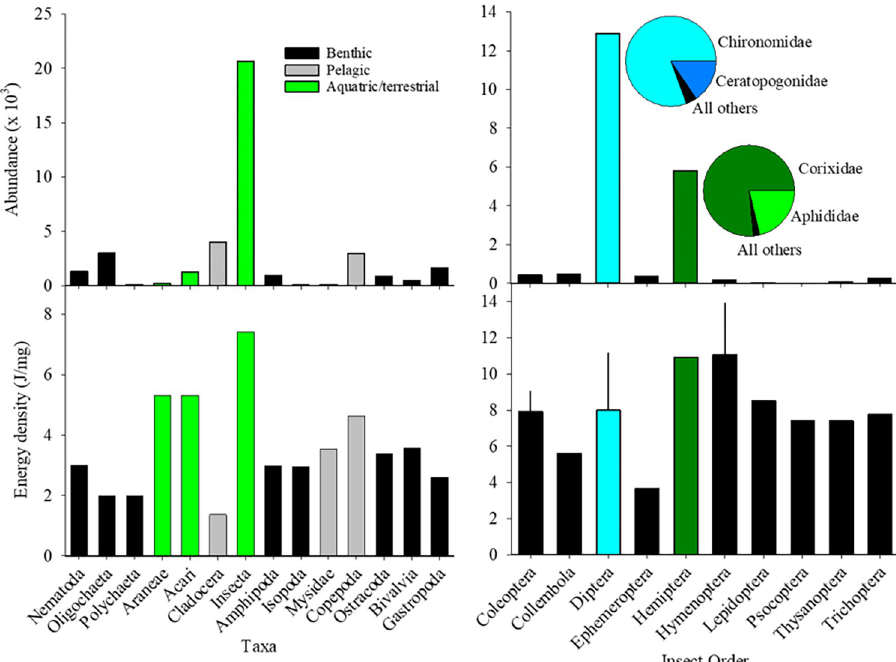
Fig 3. Abundances of taxa (top panels) and corresponding mean energy densities (bottom panels) from plankton samples during 2016 and 2017 combined. Left panels: phyla color-coded for primary habitat. Right panels: Insect orders, highlighting dipterans and hemipterans. Error bars for insect orders are standard deviations where sufficient data were available.